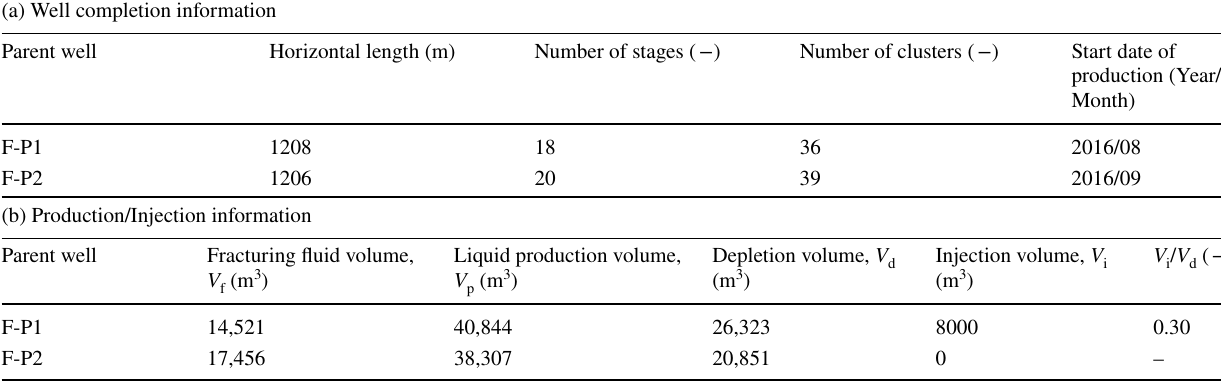
Table 8 Well completion, production, and injection information of the two parent wells (F region) (a) Well completion